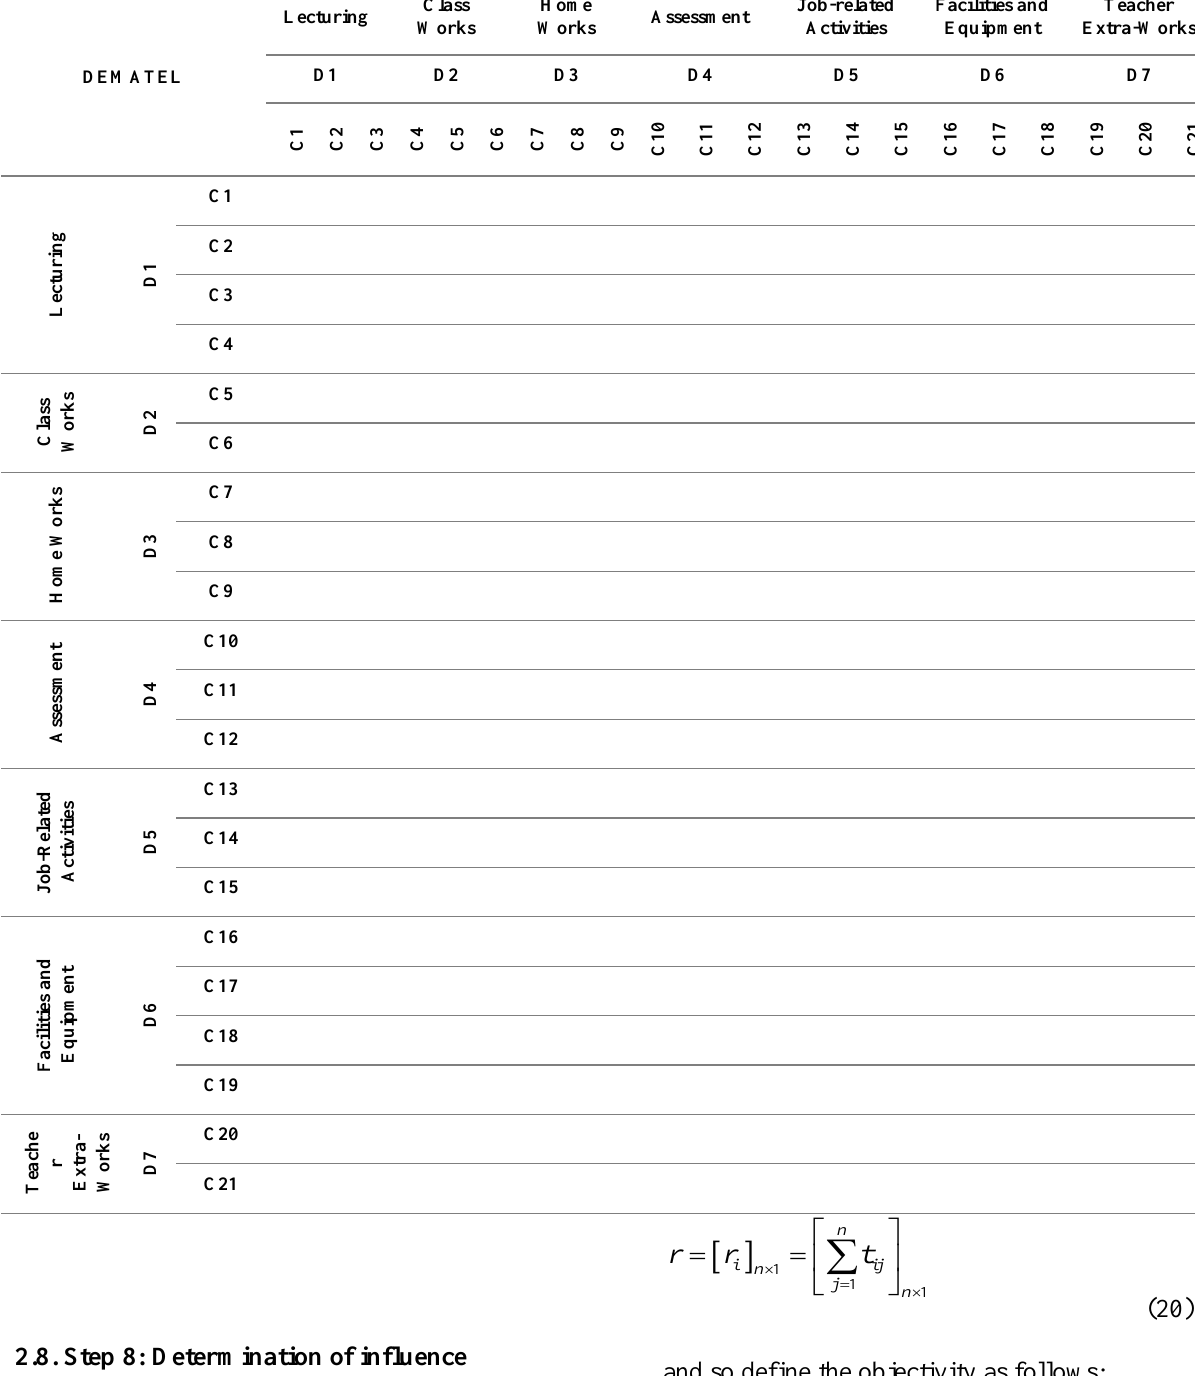
Table 3. Questionnaire (matrix) of direct influences given to each expert.